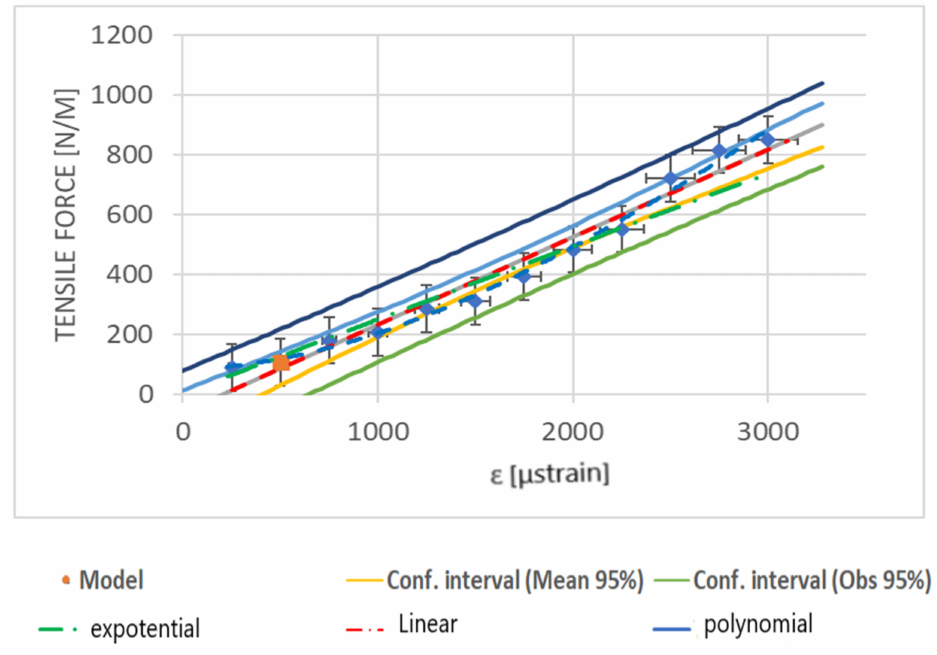
Figure 16. Calibration testing of the geogrid with an optical FBG sensor. The obtained calibration chart makes it possible to determine the value of the load occurring in the geogrid based on the measurement of the grid strain using an FBG